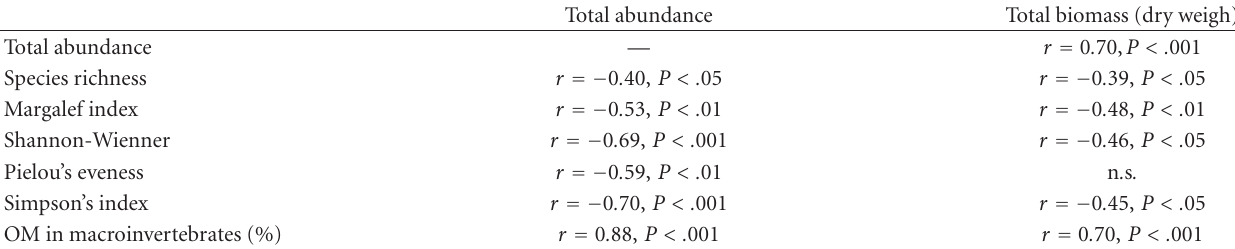
Table 4: Significant Pearson correlation coe ffi cients r (Pearson r , P < . 05) between total abundance, total biomass, diversity indices, and percentage of organic matter in macroinvertebrate communities. Total